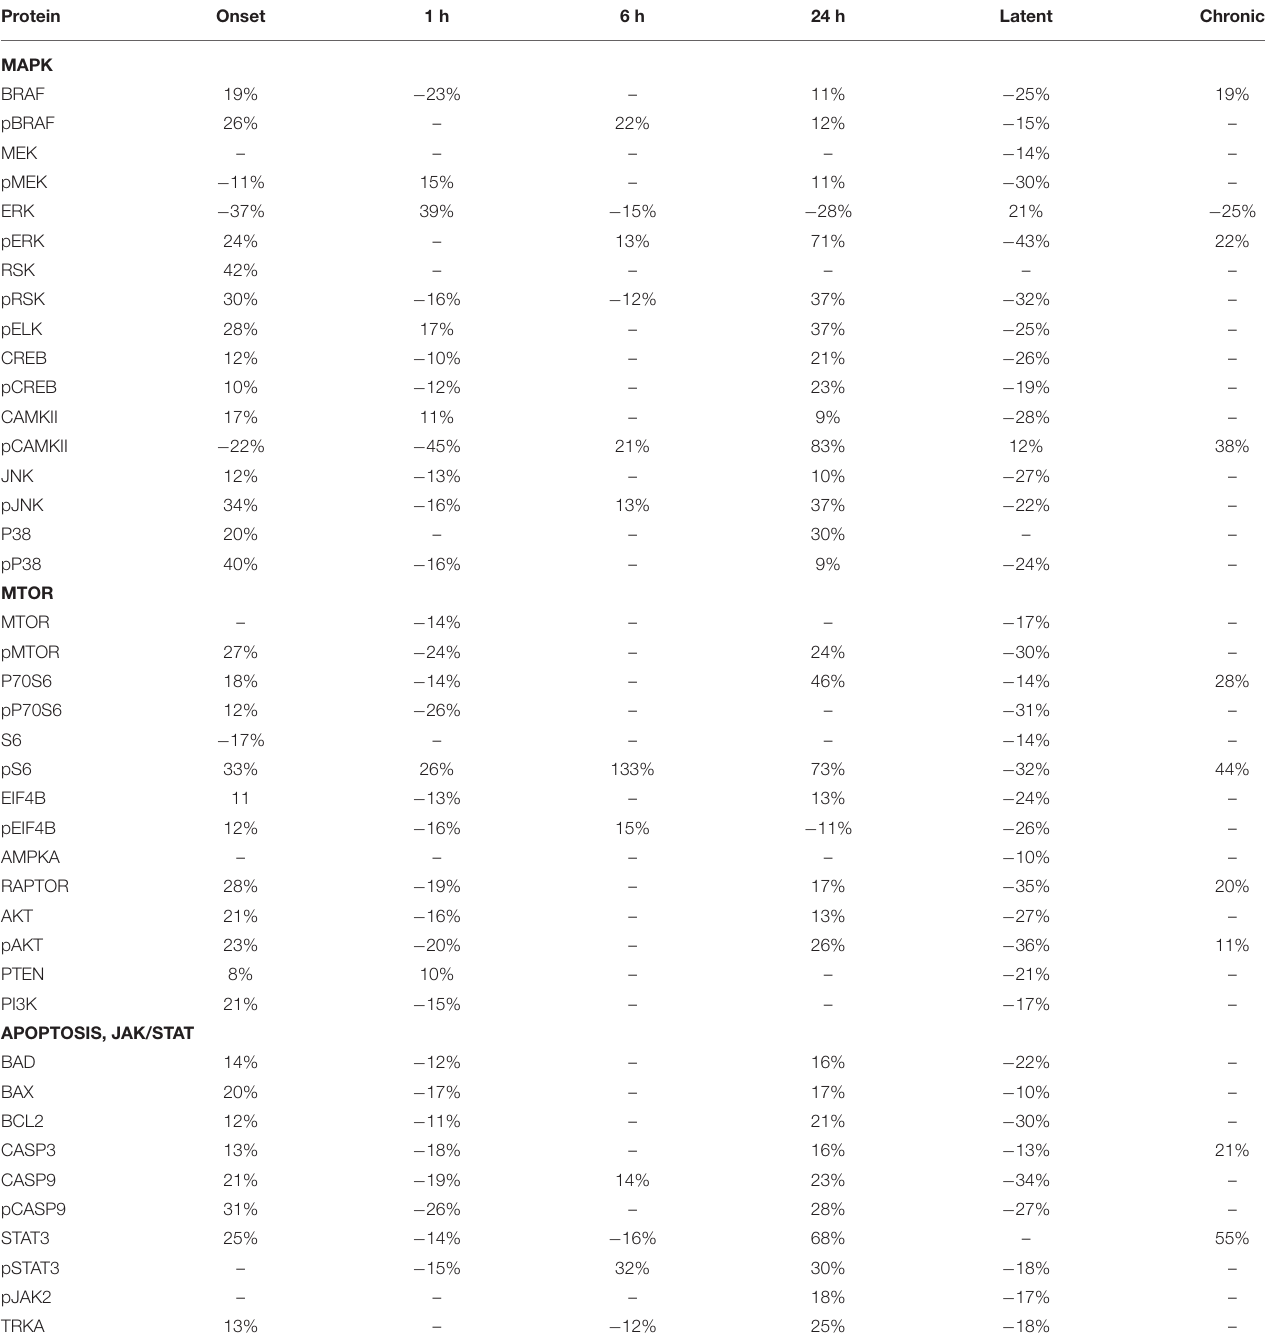
TABLE 2 | Protein changes in hippocampus, MAPK, MTOR, JAK/STAT, and apoptosis pathway components (pilocarpine vs. saline at corresponding time points). Protein Onset 1 h MAPK